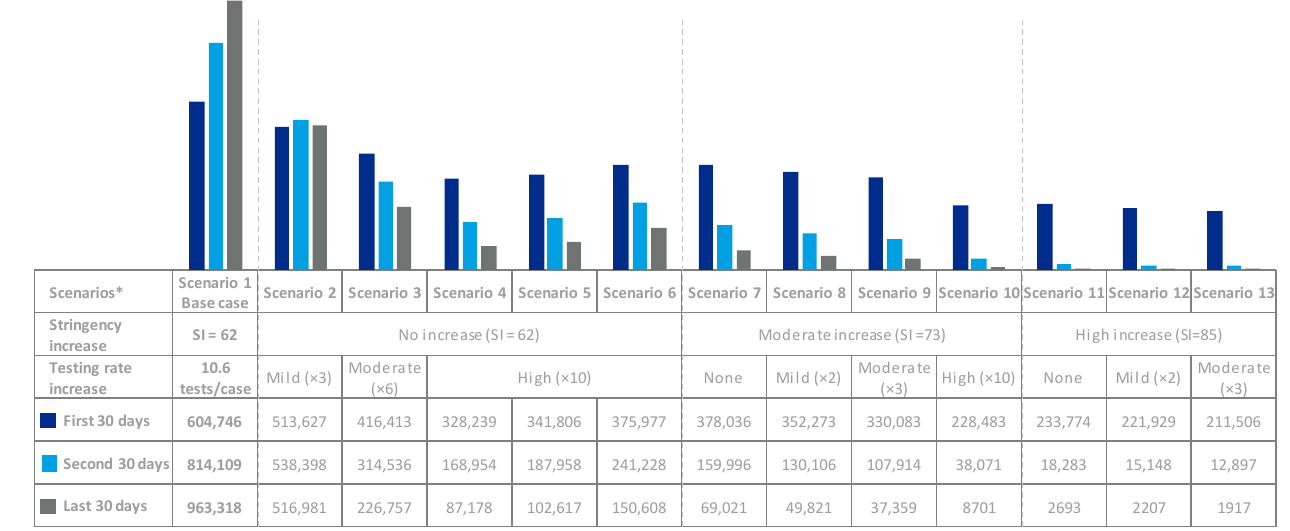
Figure 3 . Exposed cases by 30-day period and scenario . * All scenarios consider a sensitivity of 96% except scenario 5 (89% Figure 3. Exposed cases by 30-day period and scenario. * All scenarios consider a sensitivity of 96% except scenario 5 (89% sensitivity) and scenario 6 (73.3% sensitivity). sensitivity) and scenario 6 (73.3%